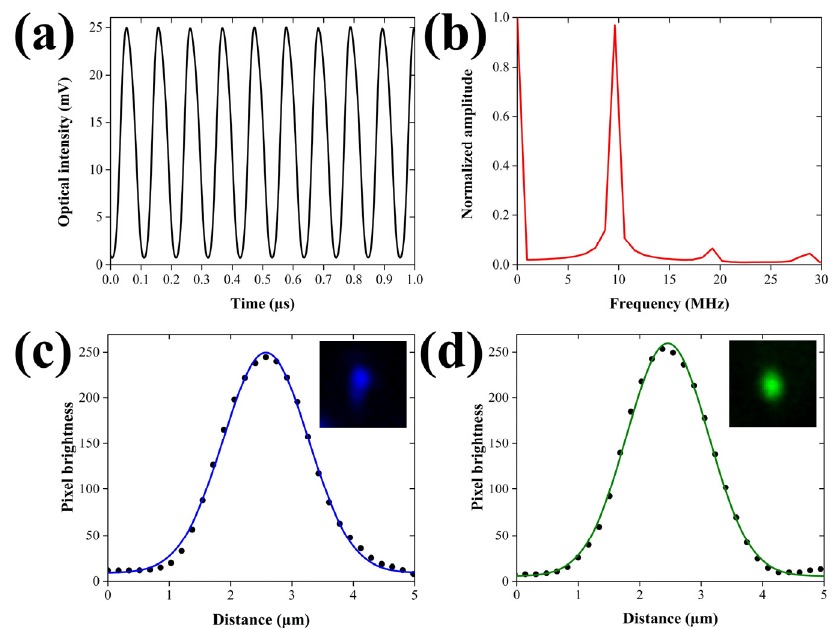
Figure 2. Temporal and spatial characterization of the excitation beams. ( a ) Temporal modulation of the excitation laser’s intensity ( λ = 488 nm) as measured by a fast photodiode. ( b ) Normalized amplitude spectrum of the temporal profile shown in ( b ), demonstrating a predominant peak at 9.5 MHz. ( c ) Lateral profile of a 520 nm fluorescent microsphere with fitted Gaussian curve, using the 488 nm wavelength. The inset shows the 2D image of the microsphere (field of view: 8.24 × 8.24 µ m 2 ). ( d ) Lateral profile of a 520 nm fluorescent microsphere with fitted Gaussian curve, using the 532 nm wavelength. Similarly, the inset depicts the 2D image of the microsphere for an equal field of view.